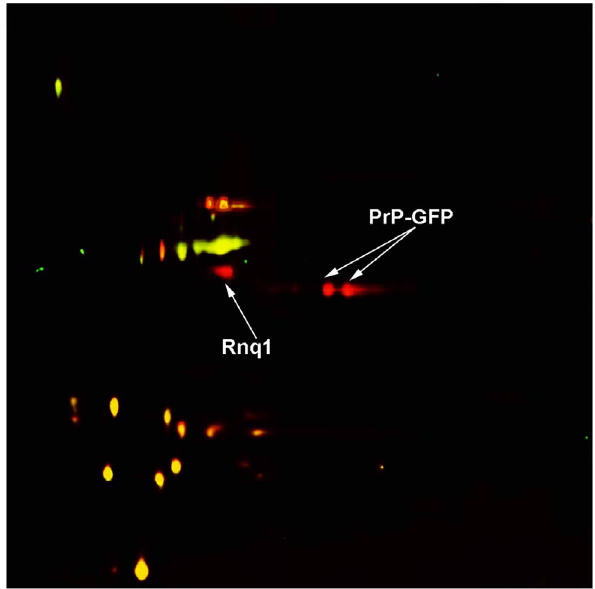
Fig. 3. 2D-DIGE image of proteins of sarkosyl-insoluble aggregates isolated from the BY4742 [ PIN + ] strain expressing PrP-GFP and from its [ pin 2 ] derivative expressing non-fused GFP. Spots corresponding to proteins from [ PIN + ] cells expressing PrP-GFP are red, while those from GFP-containing cells (control) are green. Yellow spots correspond to proteins present in both compared samples. Identification data are presented in Table 2; mass spectra are shown in S2